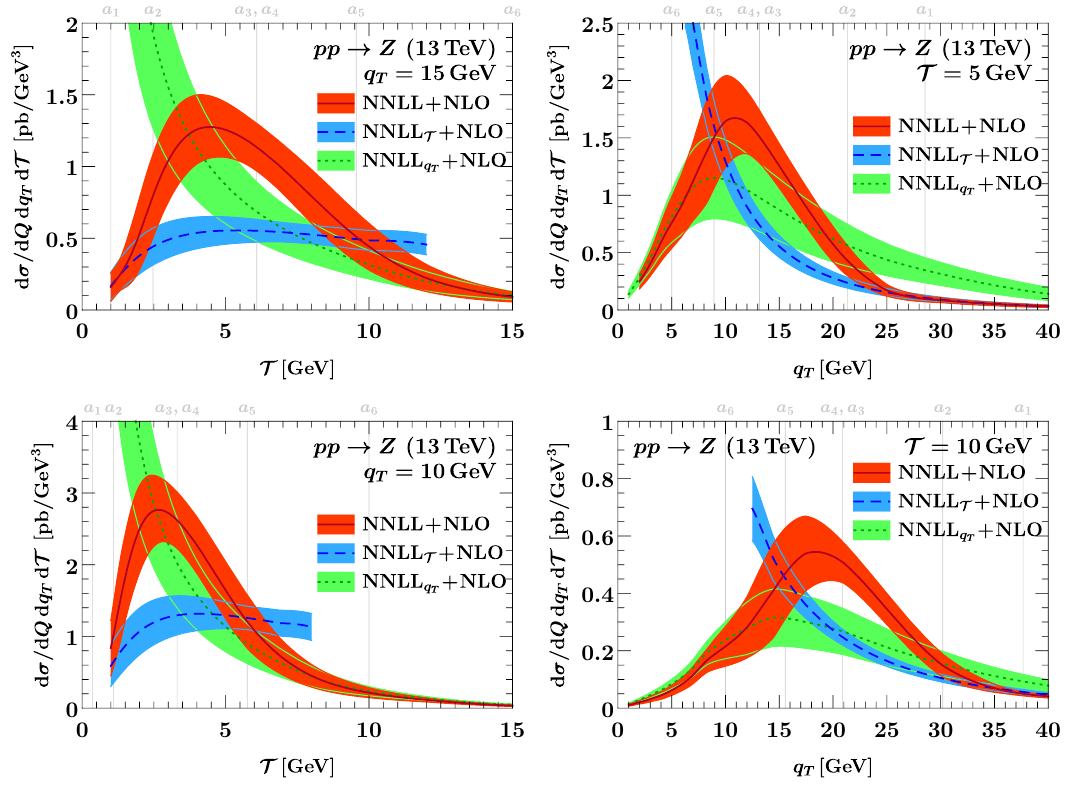
Figure 18 . The double-di(cid:11)erential Drell-Yan cross section for (cid:12)xed q T , as a function of T (left) and for (cid:12)xed T , as a function of q T (right). The solid red curves are slices of the surface plots shown in the top left panel in (cid:12)gure 16, up to Jacobians. The blue dashed (green dotted) curve corresponds to the middle (bottom) panel of (cid:12)gure 15. The thin vertical lines indicate the transition points a i described in section 3.3. The SCET I prediction (dashed blue) has an unphysical edge at T = q T , see (cid:12)gure 15, and is not shown beyond T = 0 : 8 q T to avoid distraction. See the text for details on the uncertainty